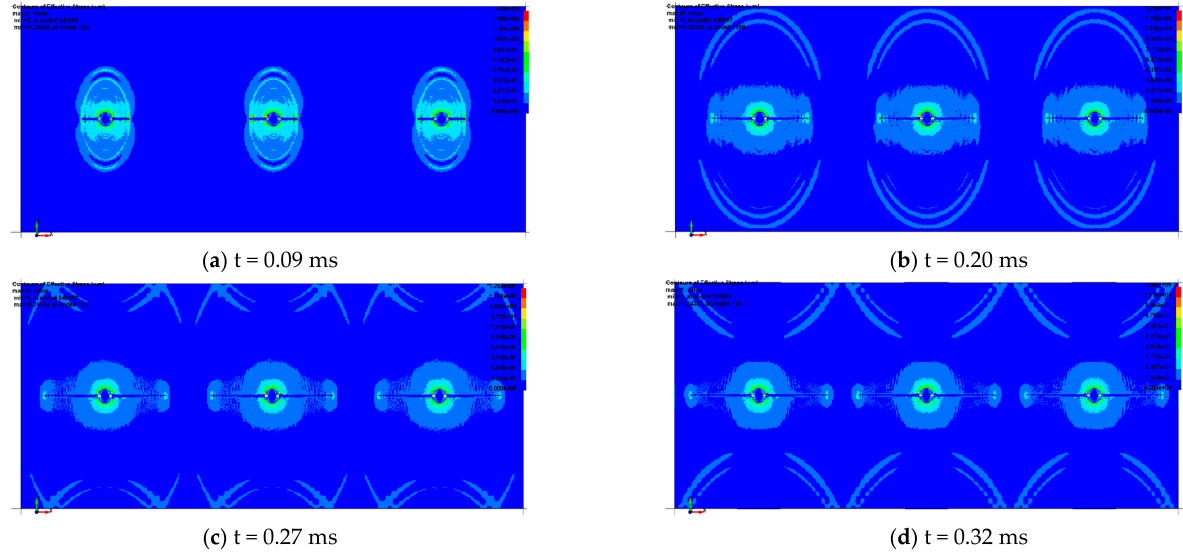
Figure 26. Stress evolution process of 600 mm spacing multi-hole shaped charge blasting.